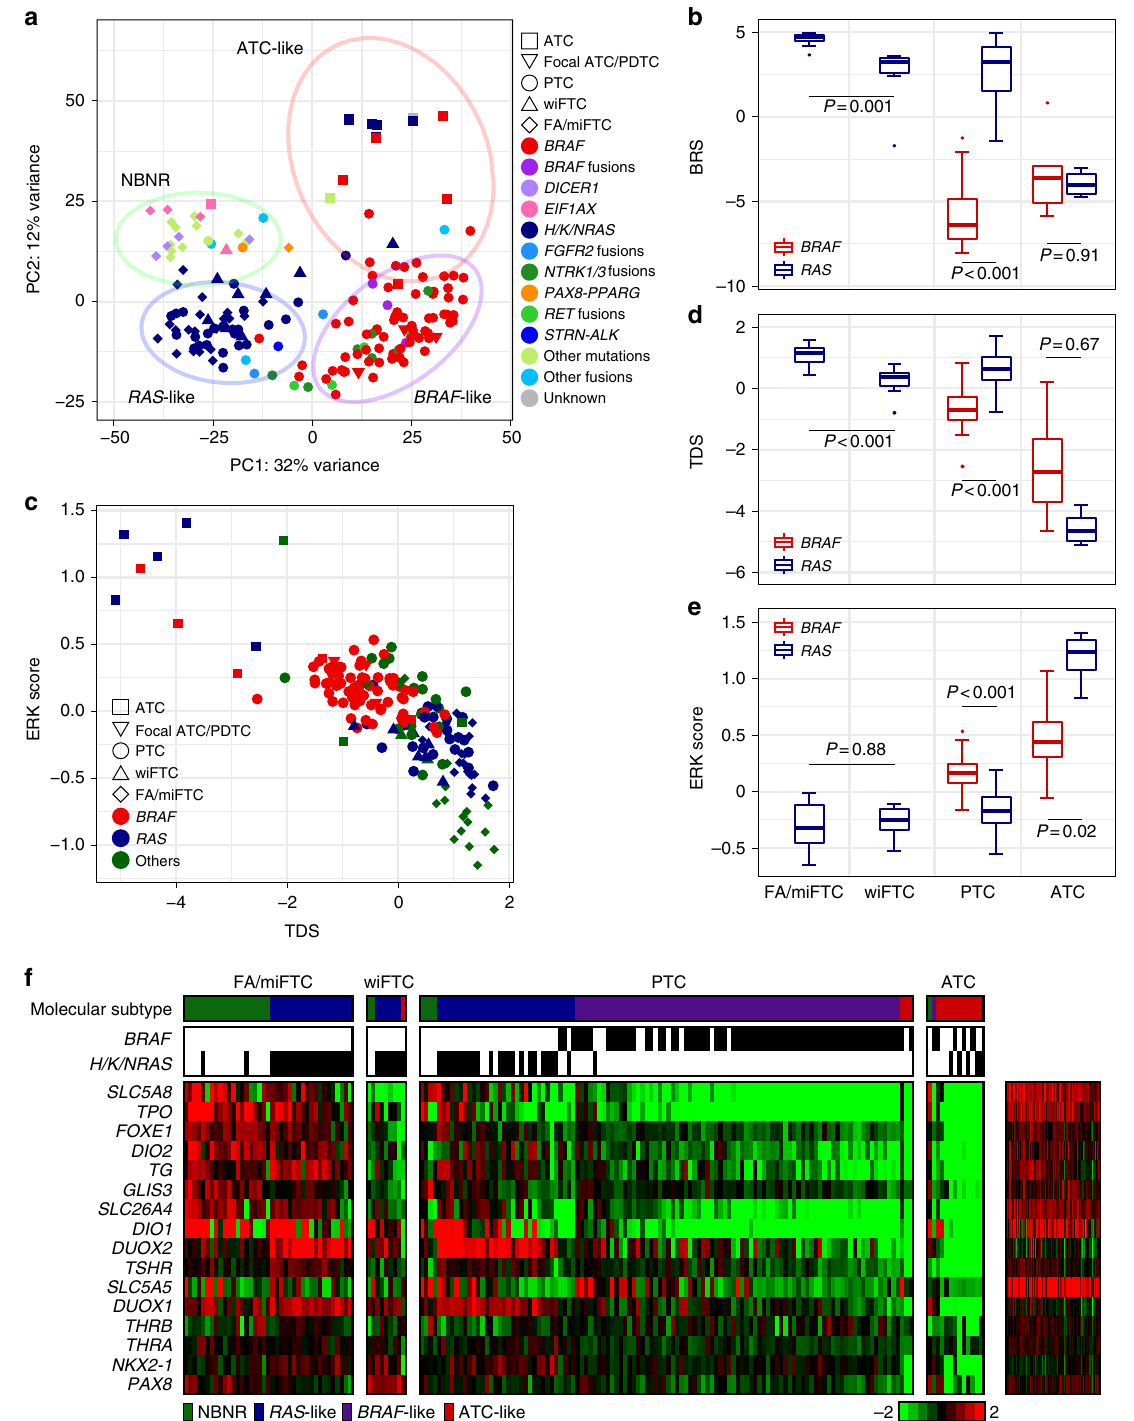
Fig. 4 The transcriptome landscape of ATC and advanced DTCs. a The result of K -means clustering via PCA. The types of tumors and driver mutations were represented by shape and color, respectively. b The results of BRAF V600E -RAS score (BRS) analysis were represented by box plots. P -values from two-tailed Mann – Whitney U -test were represented. c TDS and ERK score were displayed on a scatter plot. d The results of TDS analysis and e ERK score analysis were represented by box plots. P -values from two-tailed Mann – Whitney U -test were represented. f The heatmap represents the expression pro fi le of 16 genes associated with thyroid function and metabolism in TCs. The right panel represents gene expression levels in normal thyroid